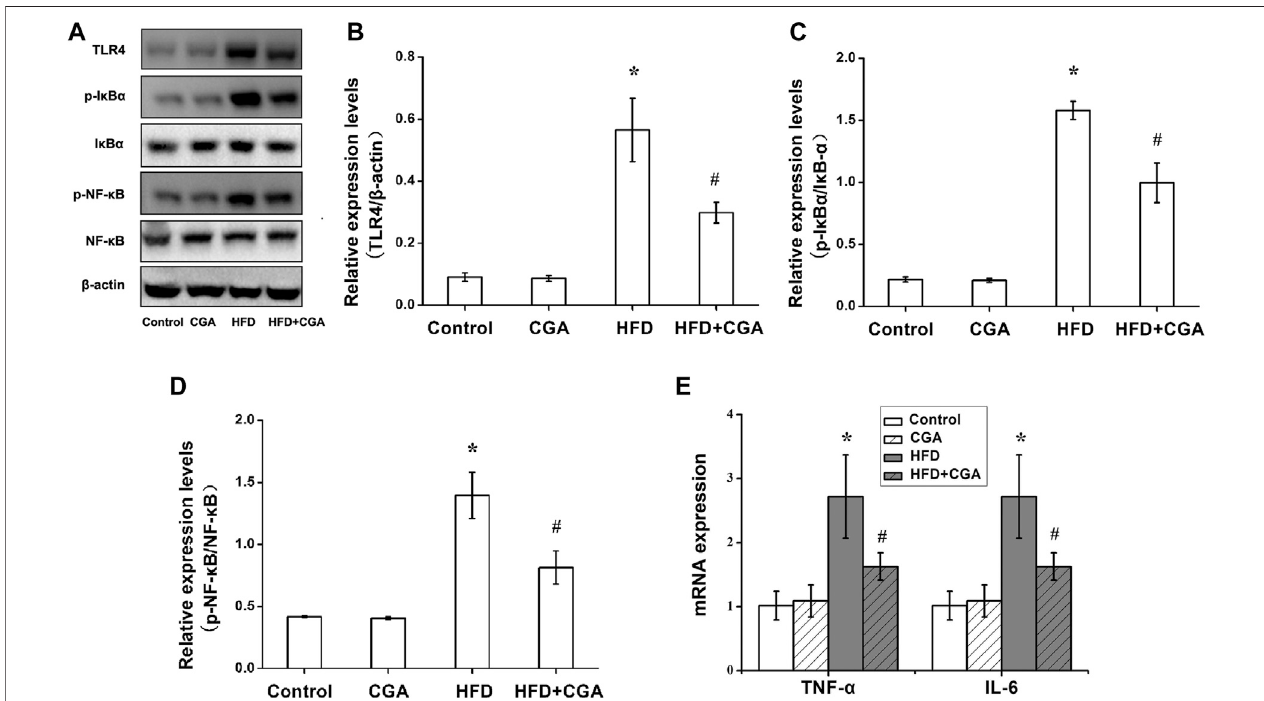
FIGURE3| EffectsofCGAontheTLR4/NF- κ Bsignalingpathwayandin fl ammatorycytokinesintheliver. (A) TLR4/NF- κ Bsignalingpathwayanalyzedwithwestern blot. (B) TLR4 expression. (C) p -I κ B α /I κ B α expression (D) p-NF-kB/NF-kB expression. (E) expression of TNF- α and IL-6 analyzed with real-time PCR. Data are presented as mean ± SD. * p < 0.05 as compared with the control group; # p < 0.05 as compared with the HFD